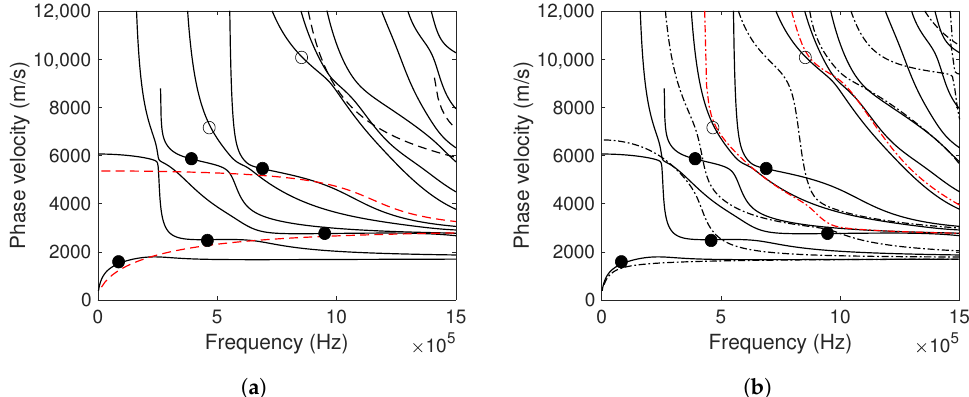
Figure 7. Combined phase velocity dispersion curves of: ( a ) the 2mm aluminium plate (dashed lines) and the 6mm aluminium-CFRP plate (solid lines); and ( b ) the 4mm CFRP plate with a [90/0/90/90] layup (dash-dotted lines) and the 6mm aluminium-CFRP plate (solid lines). The filled and hollow circles mark modes that did and did not interact with a 1mm crack in aluminium, respectively. Red dashed lines mark two aluminium modes in the aluminium, red dash-dotted lines mark two CFRP modes. Recreated from original data from